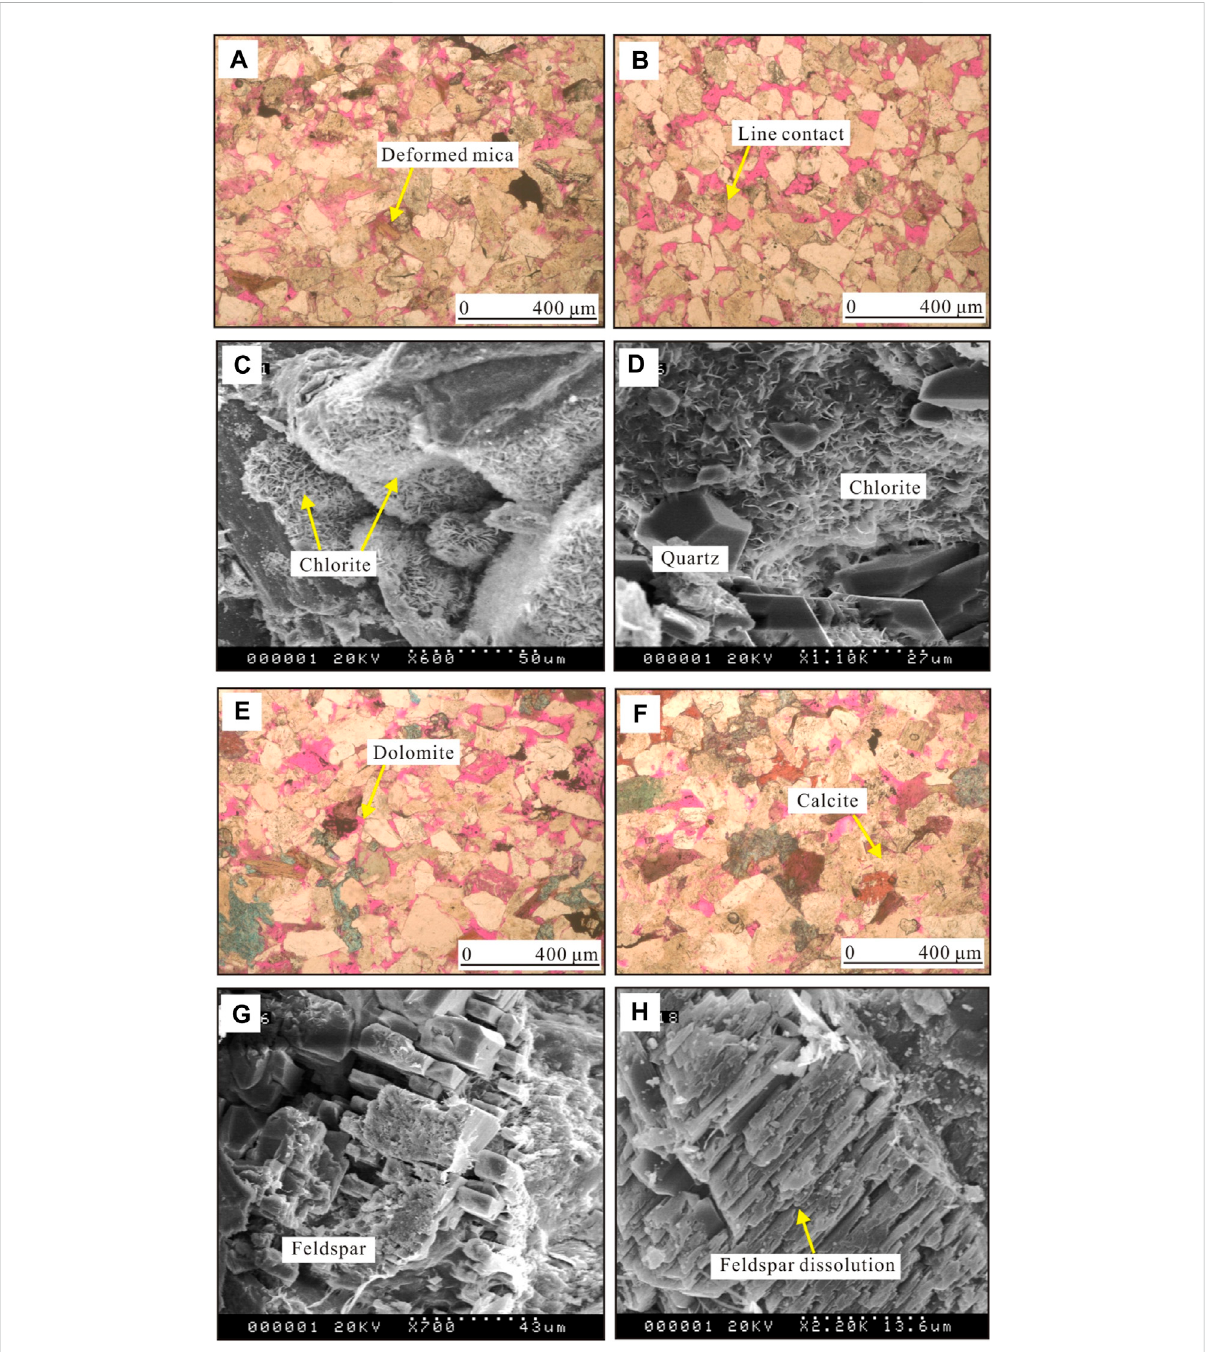
FIGURE 5 MicrostructuralcharacteristicsoftheChang1Membersandstoneinthestudyarea. (A) Deformedsheetmica,WellNan141; (B) Mosaicandlinear contact particles, Well Nan128; (C) Chlorite cementation, Well Nan141, 521.97 – 522.07 m; (D) Quartz- fi lled and chlorite-cemented intergranular pores, Well Nan128, 715.83 – 715.93 m; (E) Dolomite and ankerite cements with grain structures are fi lled in the intergranular pores, Well Nan128, 725.18 – 725.28 m; (F) Calcite and ankerite cements with grainstructures are fi lled between particles, Well Xi41,500.89 – 500.99 m; (G) Feldspar dissolution, Well Nan128, 715.83 – 715.93 m; (H) Feldspar dissolution, Well Xi41, 500.89 – 500.99